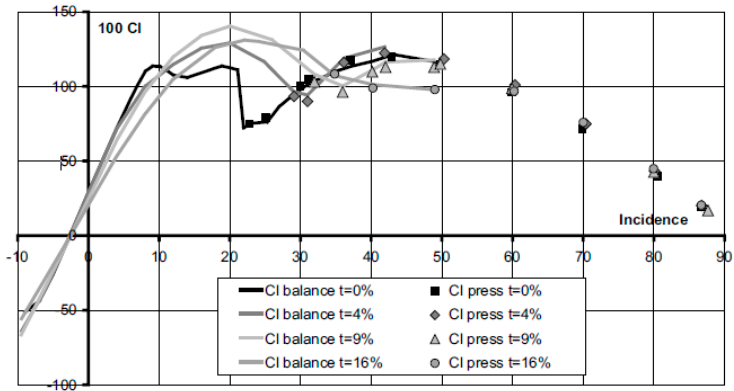
Figure 6. Effect of turbulence level ( t ) on C L of wind turbine a Re = 400,000 [84].